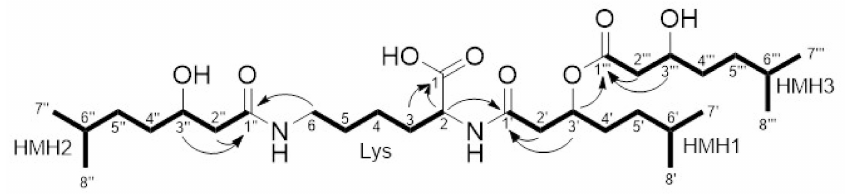
Figure 2. Observed HMBC (arrows) and selective 1D TOCSY (bold lines) key correlations of dudomycin A.